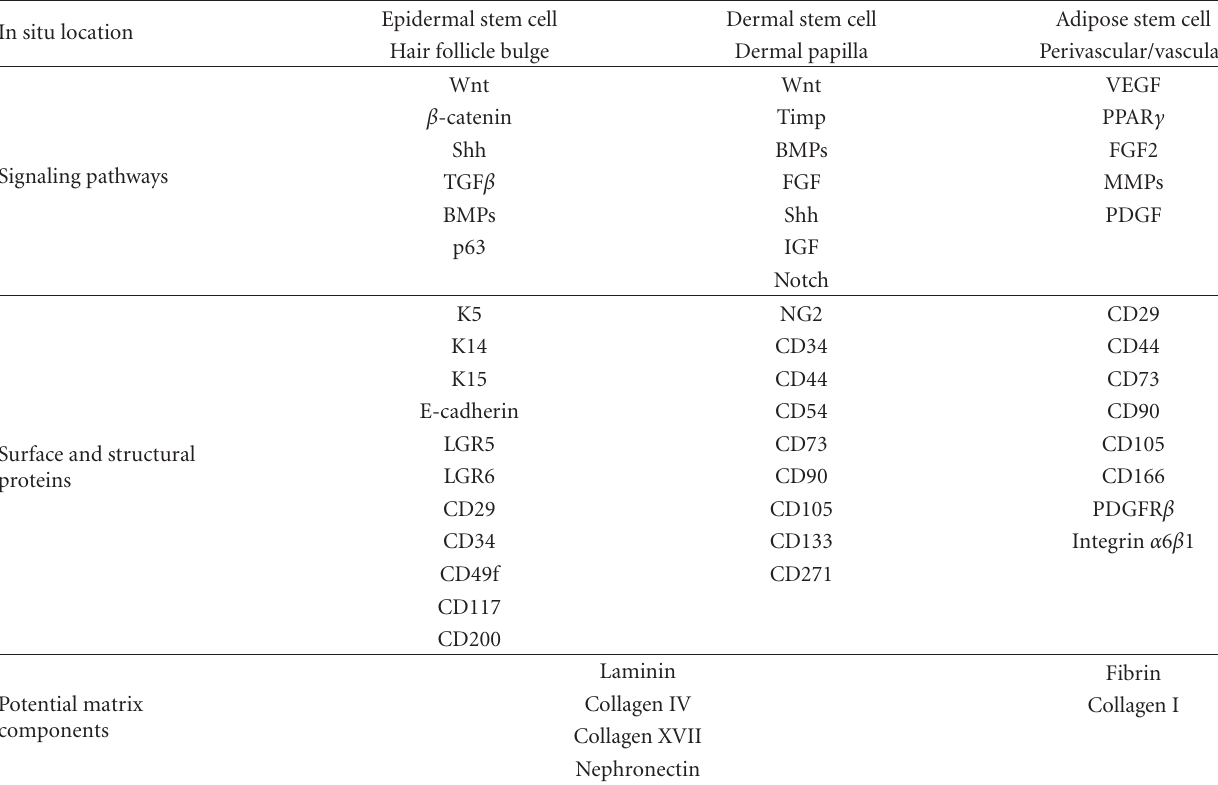
Table 1: Skin-specific stem cells and putative features of their